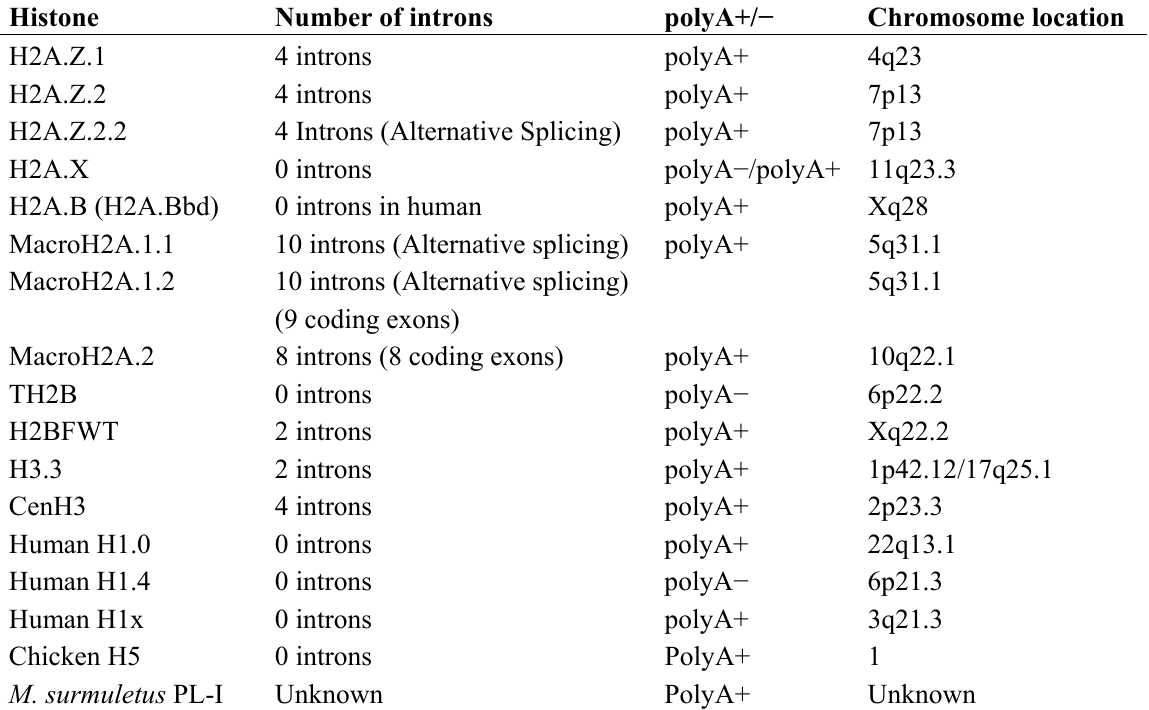
Table 1. Vertebrate Histone Variant Gene